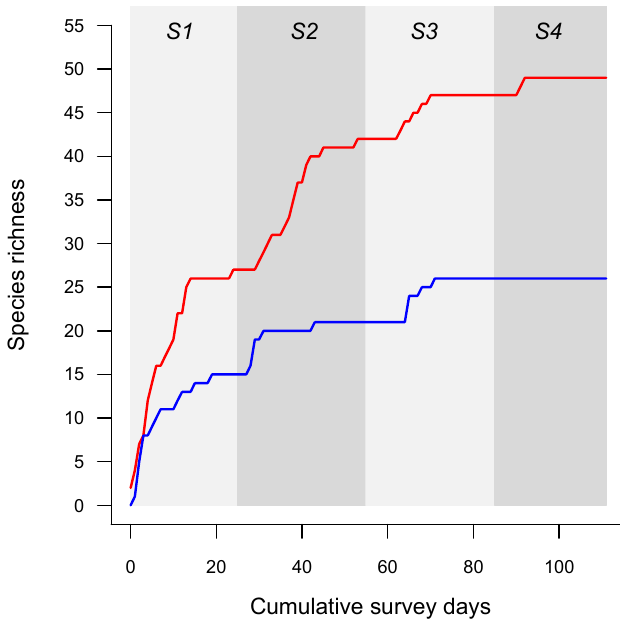
Figure 4. Cumulative numbers of species of snakes (red) and lizards (blue) during 2016–2018 fieldwork at Los Amigos Biological Station (LABS). Sampling periods: S1, March–April 2016; S2, November–December 2016; S3, November–December 2017; S4, November–December 2018.